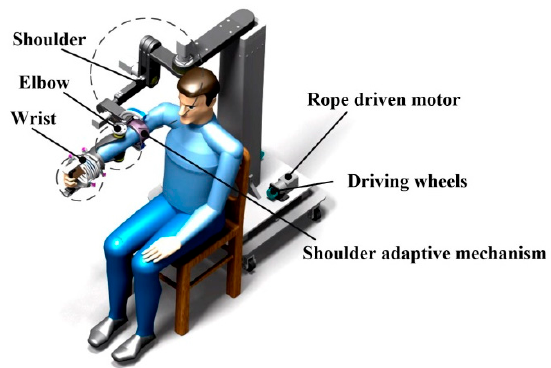
Figure 5. A 3D model of the wearable upper limb rehabilitation robot.